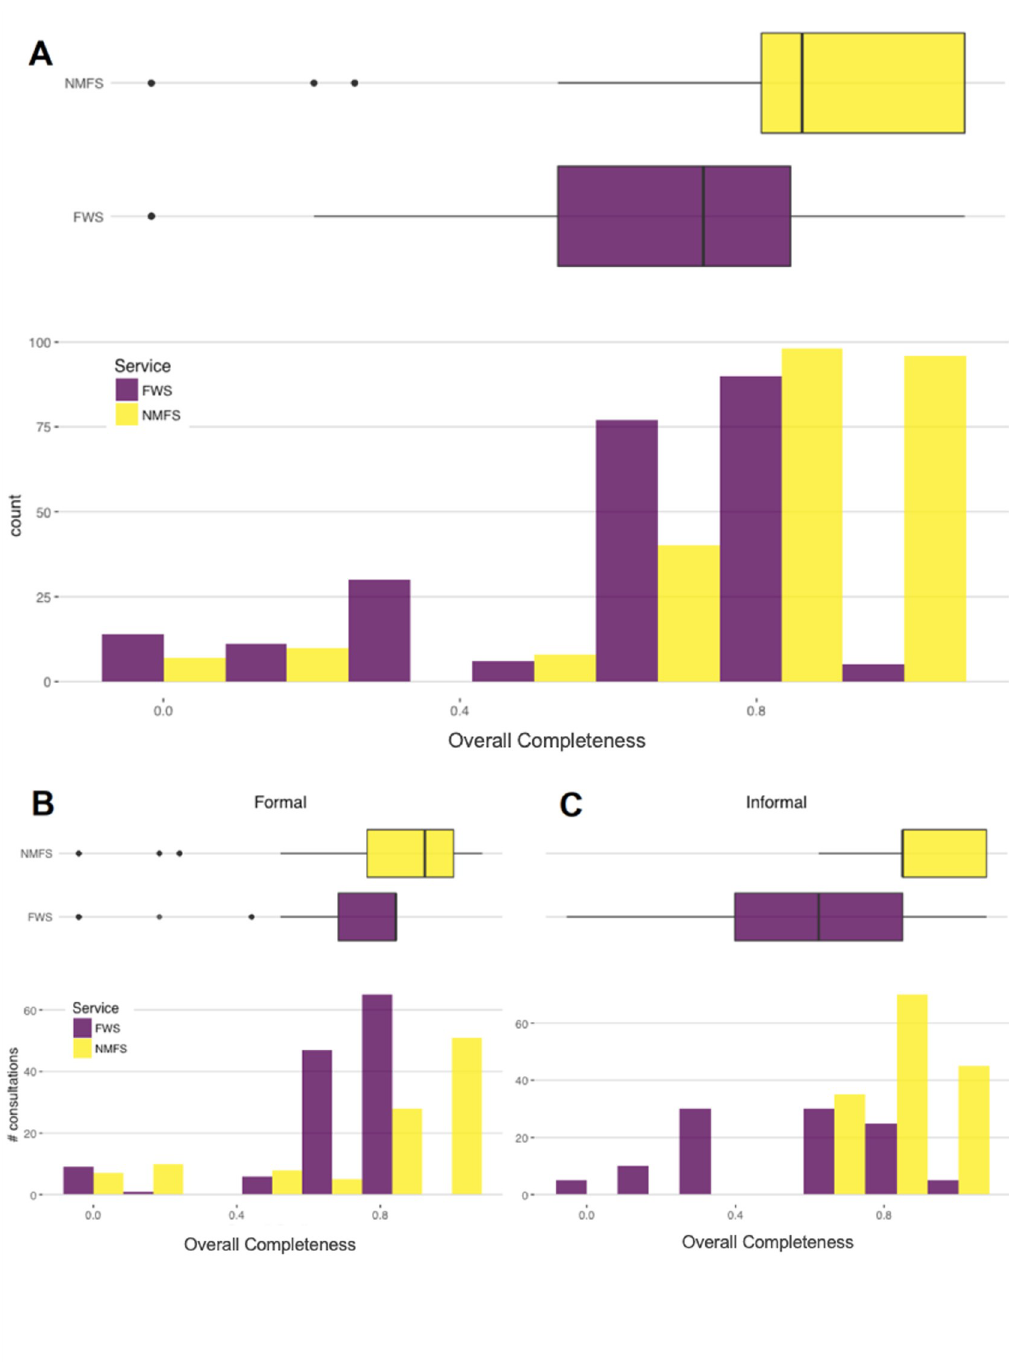
Fig 1. Completeness scores for NMFS consultations were higher on average than scores for FWS consultations across all consultations (A), formal consultations (B), and informal consultations (C). The overall completeness score for each consultation is the sum of points scored divided by the sum of points possible (see Methods for details). Top panel : Histogram and boxplots of all consultations (formal and informal, including programmatic consultations) for each Service. Bottom panel : Overall scores plotted by Service for formal and informal consultations